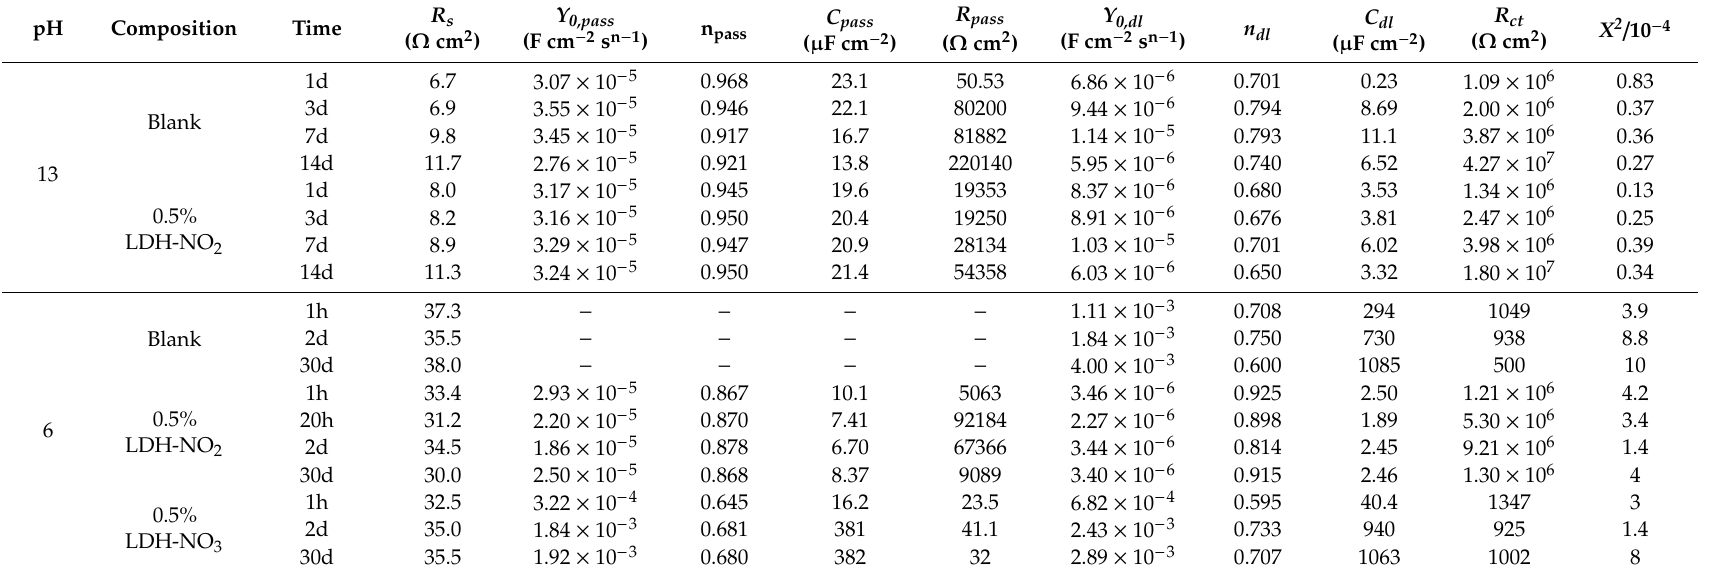
Table 1. Parameters determined by numerical fitting of the EIS spectra shown in Figure 5 with capacitances calculated using Equation